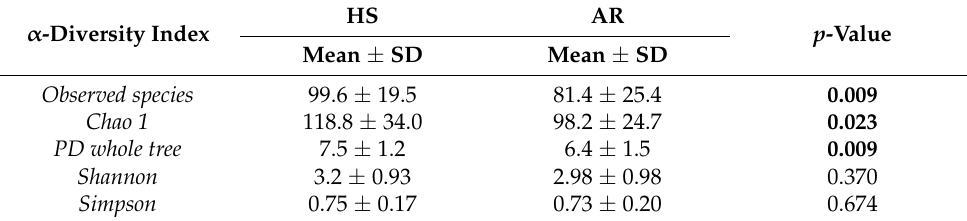
Table 4. α -diversity index in the HS and AR